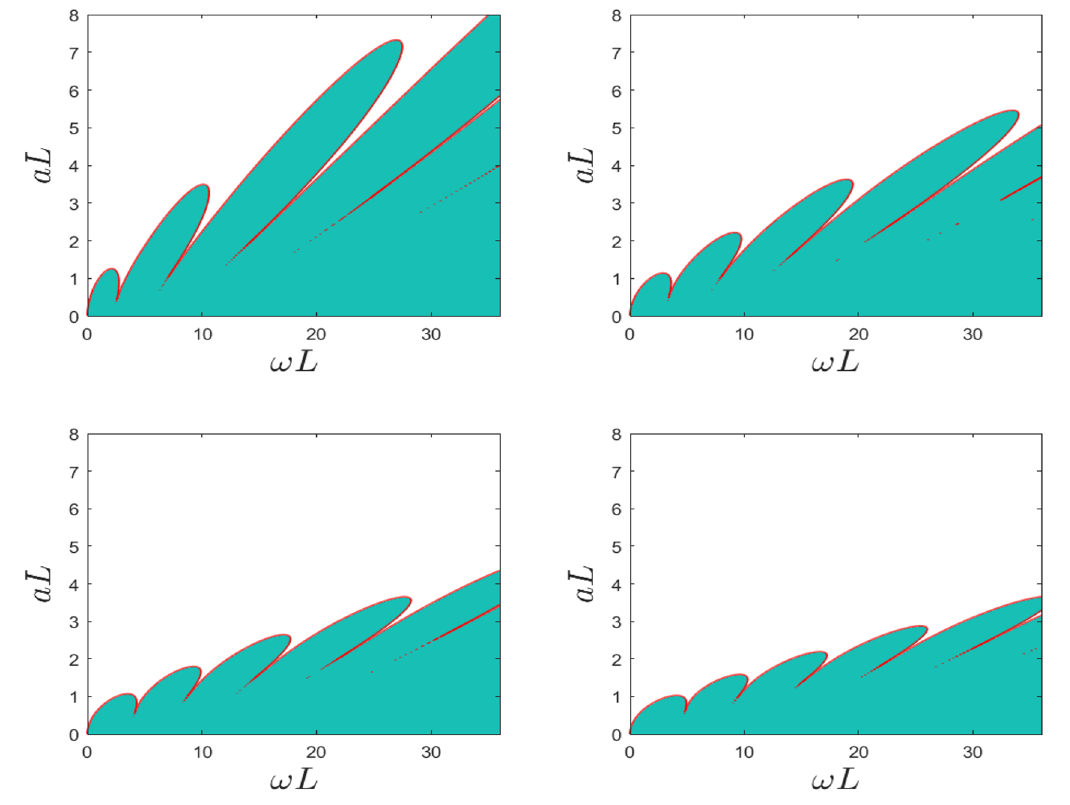
Figure 4 . Entanglement region in the ω − a plane. The four subfigures stand for D = 3 , D = 4 , D = 5 , D = 6 respectively from left to right and top to